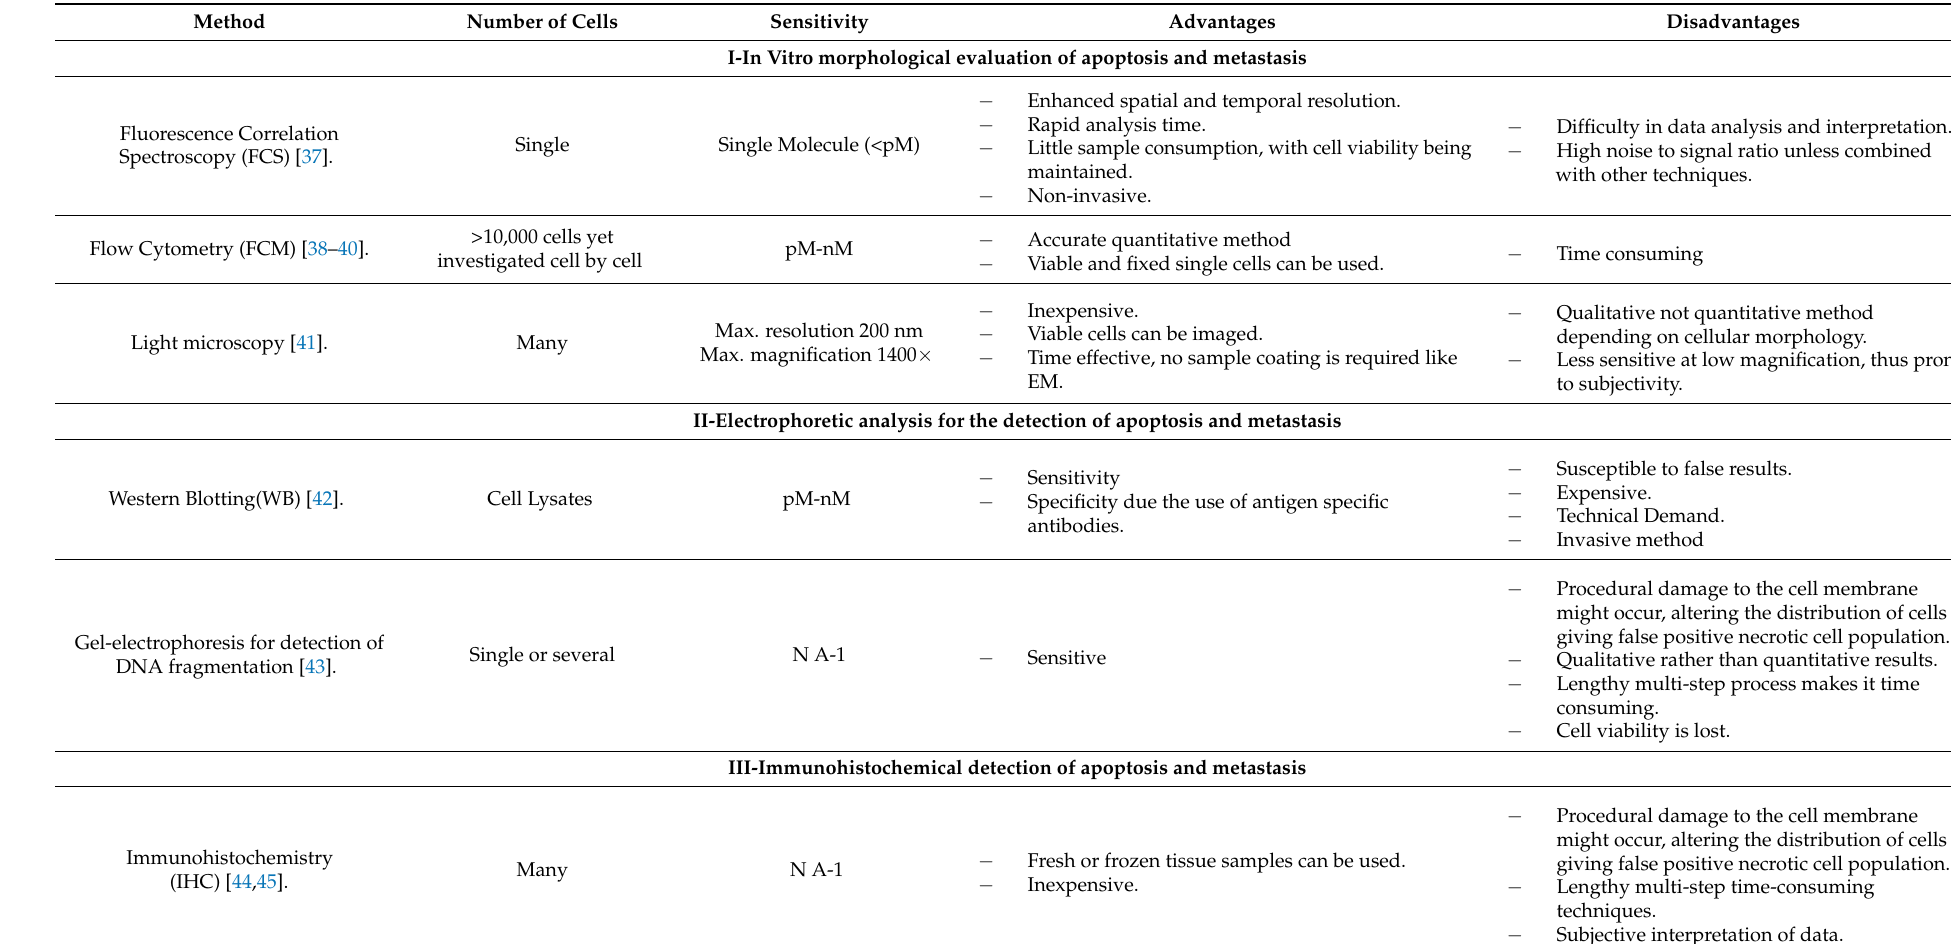
Table 1. A list of classical methods used for apoptosis and metastasis analysis